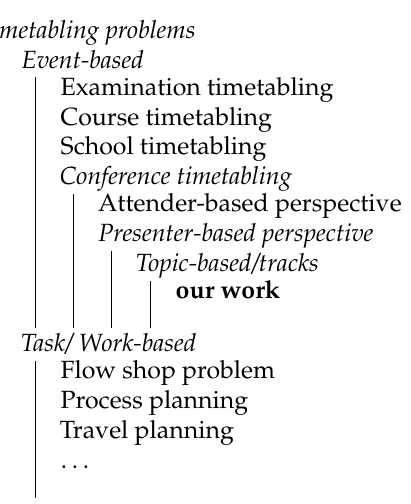
Figure 1. Timetabling problems